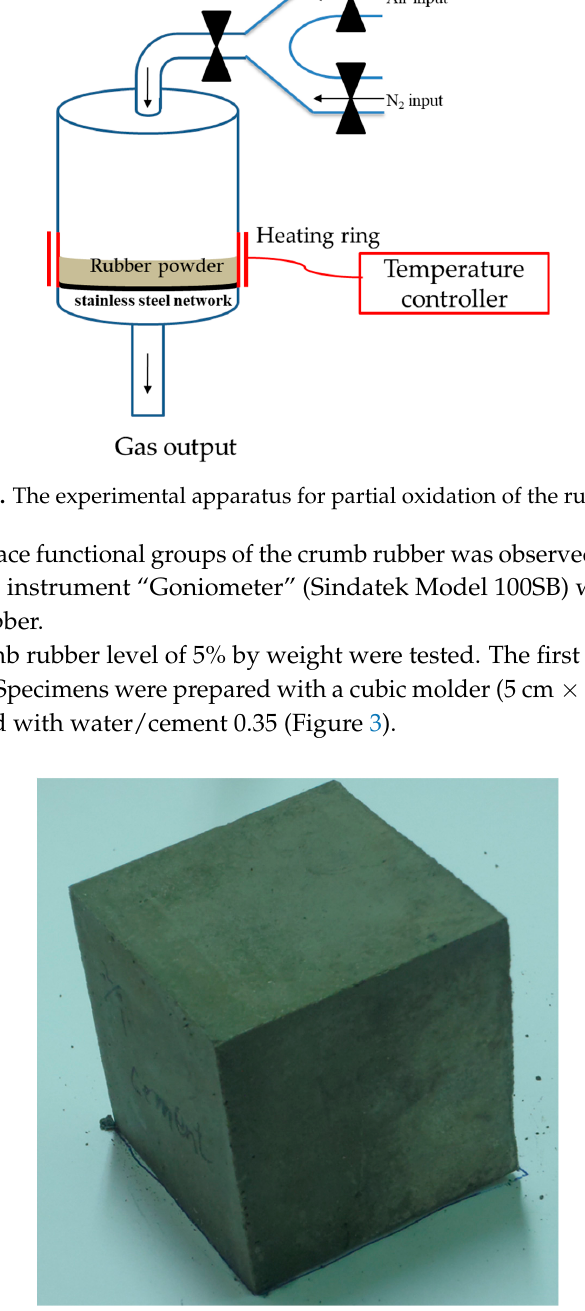
Figure 3. Specimen with dimensions 5 cm × 5 cm × 5 cm for compressive strength